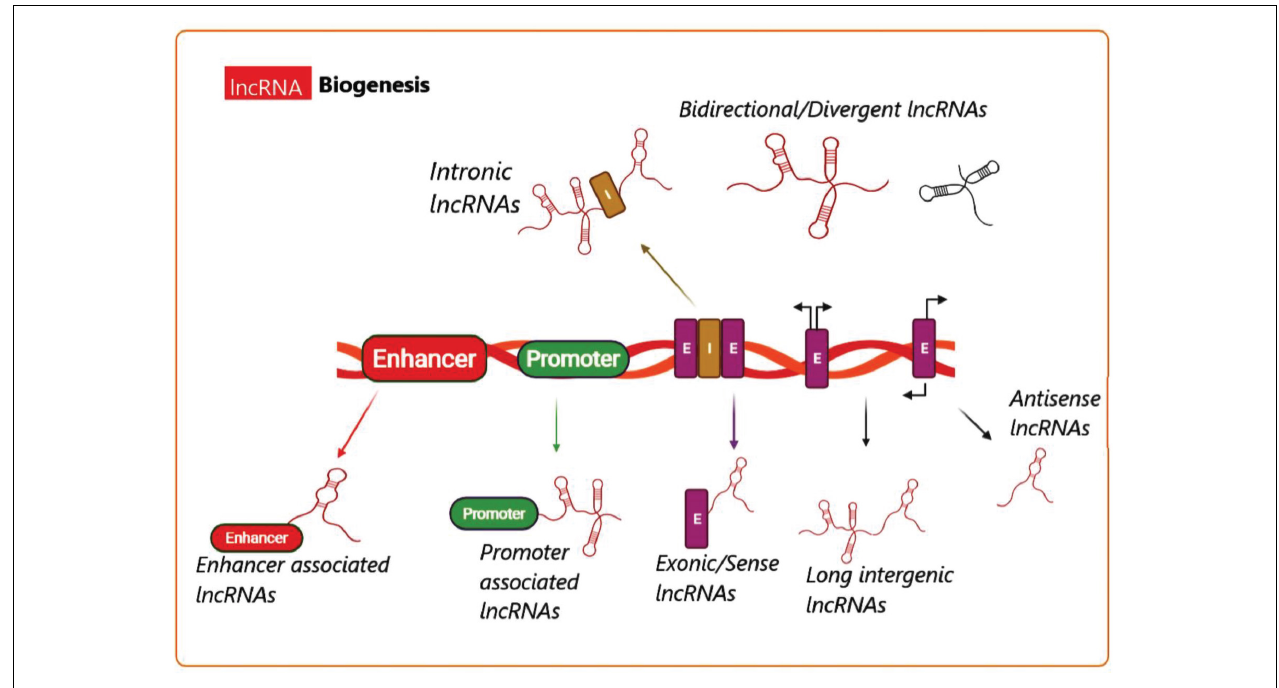
FIGURE 3 | Long non-coding RNA biogenesis. A summary of the transcriptional origins of lncRNAs. These include entire or relatively natural anti-sense transcripts (NAT), coding genes between the genes, or into the introns, promoter (green), and enhancer (red) (E, exon; I, intron).